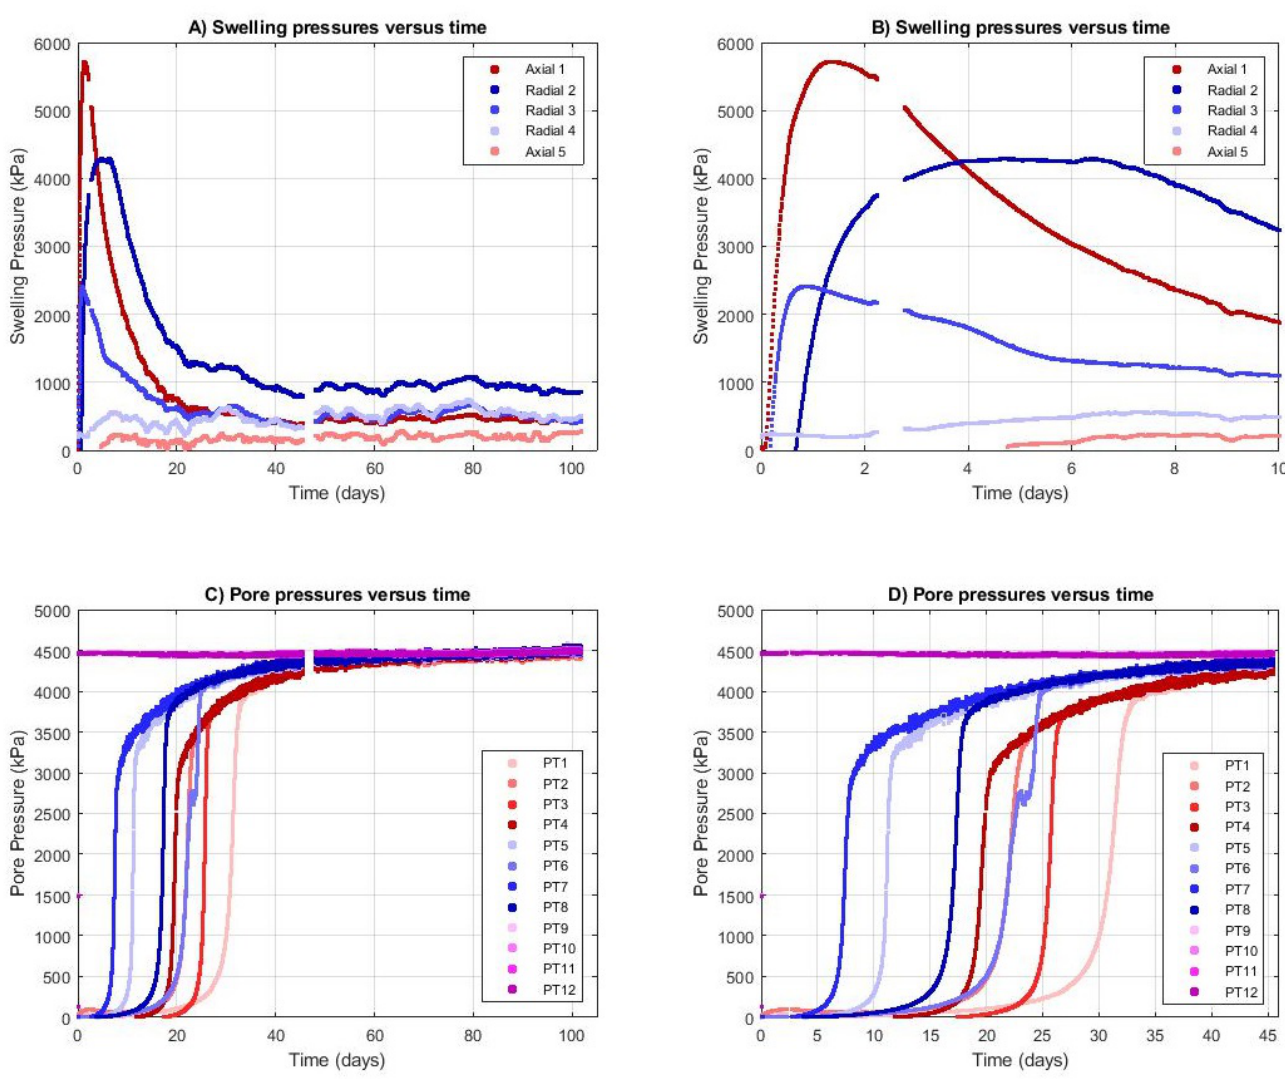
Figure 1. ( A ) Swelling pressures recorded on all sensors over the duration of the test, and ( B ) over the first 10 days. ( C ) Pore pressures recorded on all transducers over the duration of the test, and ( D ) over the first 45